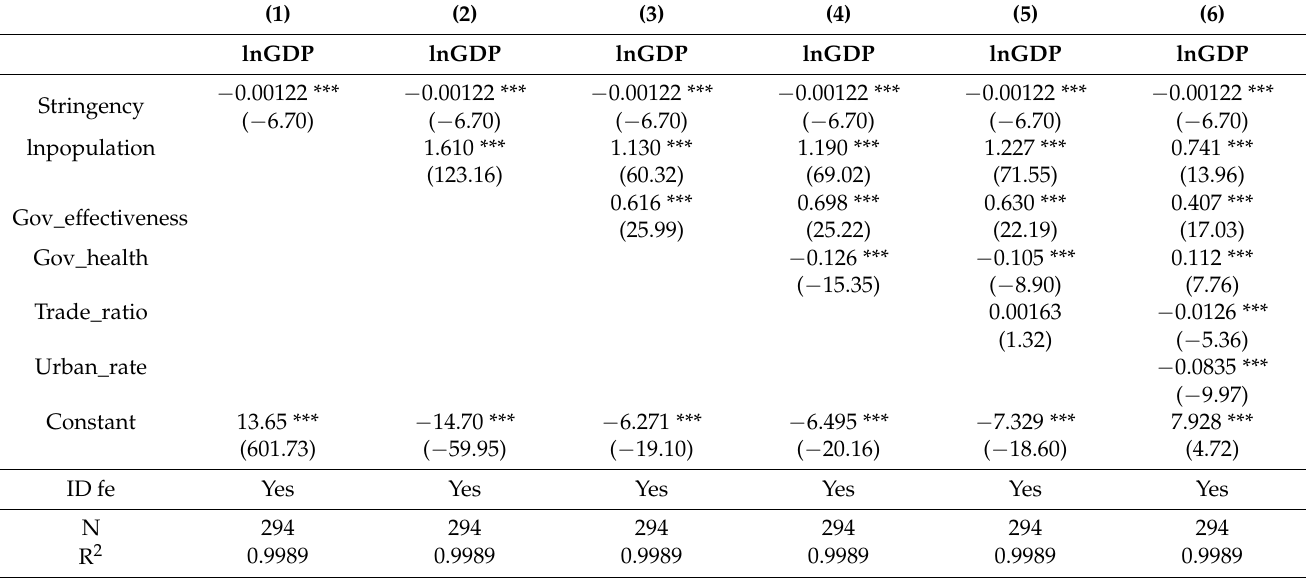
Table 4. Short-term economic impact of GRSI.